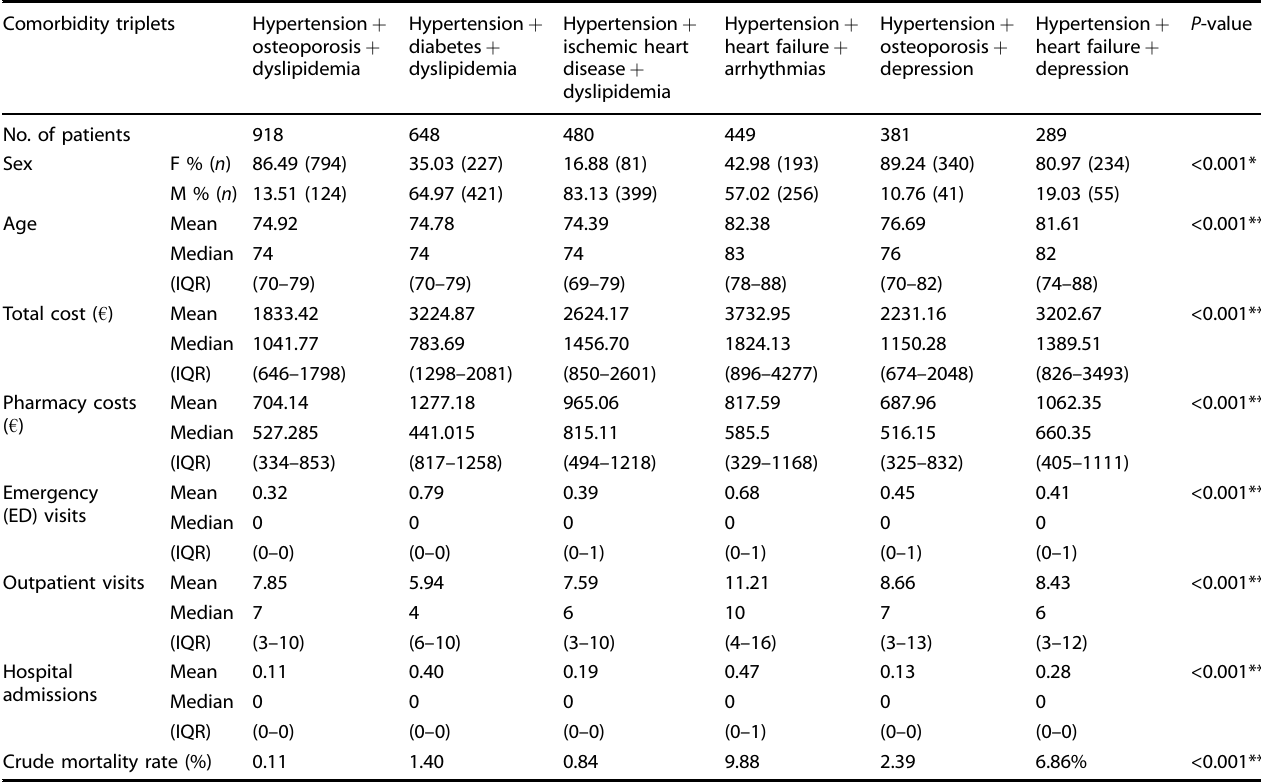
Table 1. Use of healthcare services and costs by the most common comorbidity triplets in patients with OLD over 65 years old. Comorbidity